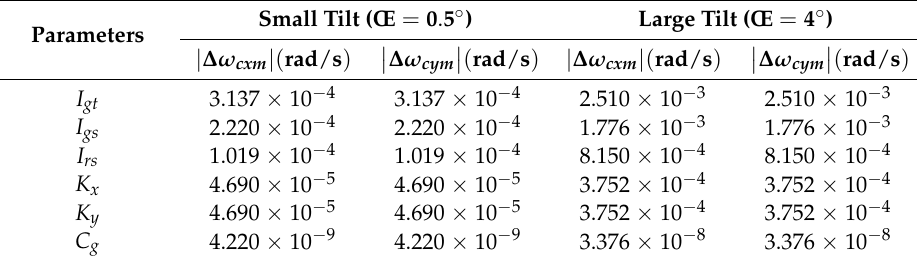
Table 2. Rate sensing errors due to parameter